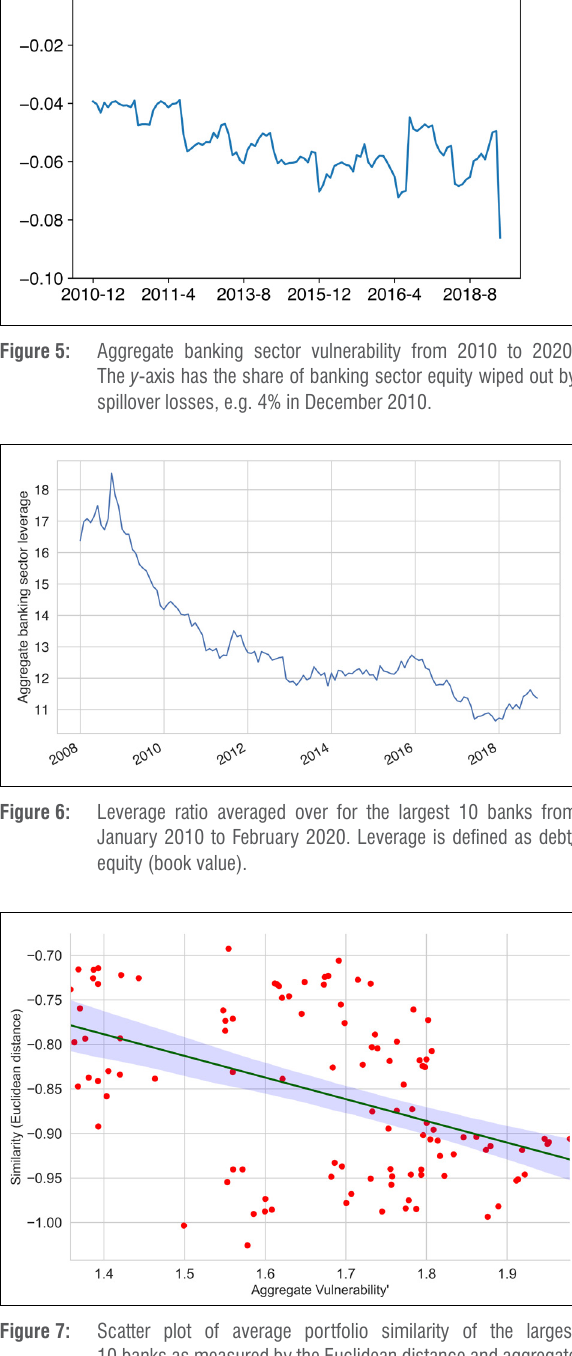
sector vulnerability of 0.8%. Hence, the hypothesis that higher similarity of portfolios in the South African banking sectors leads to higher exposure to price-mediated contagion could be confirmed. No suspicious patterns in residuals were detected in the post-regression analysis (Figure 8). Ordinary least squares regression of the log of aggregate banking sector vulnerability on the log of portfolio similarity for the largest 10 banks over the 10-year period from 2010 to 2020